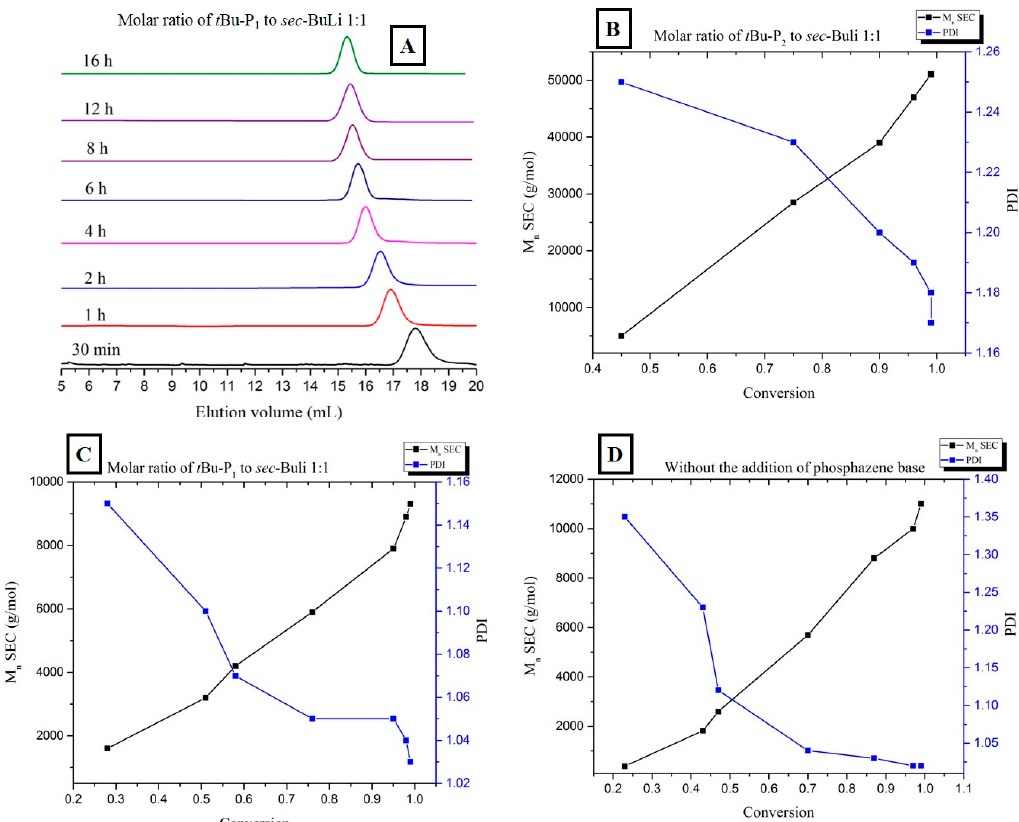
Figure 5. Kinetic plots of anionic polymerization of 1,3-butadiene in the presence of t -BuP 2 , t -BuP 1 and in the absence of phosphazene base.